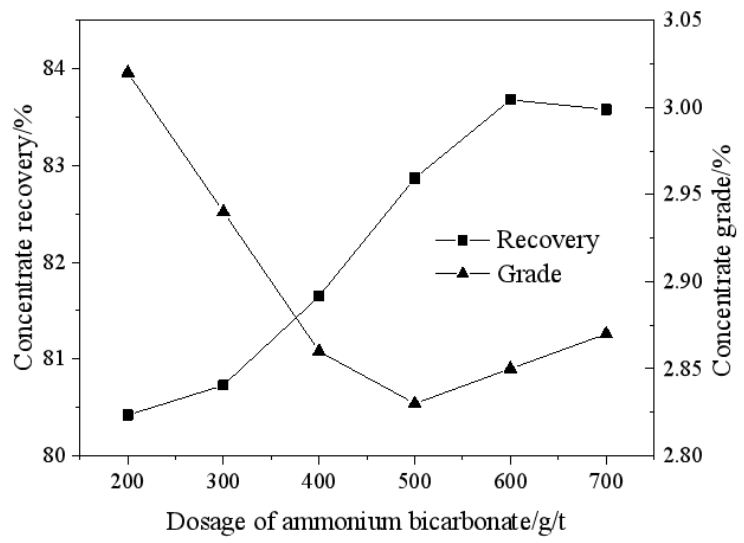
Figure 7. Influences of the ammonium bicarbonate dosage of the copper oxide flotation index.